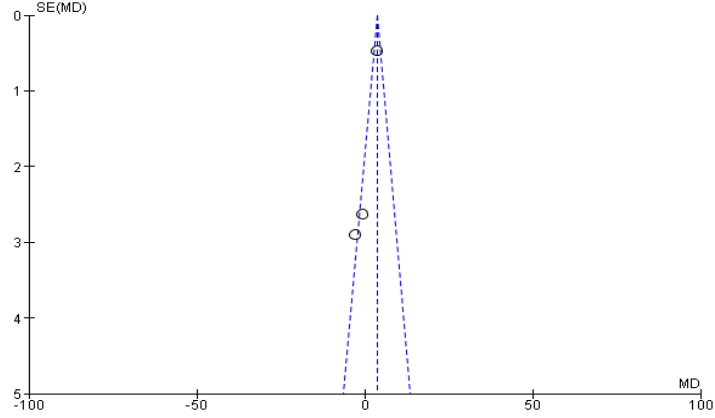
Figure 13. Funnel plot for Surgery class III between pre and post surgery.